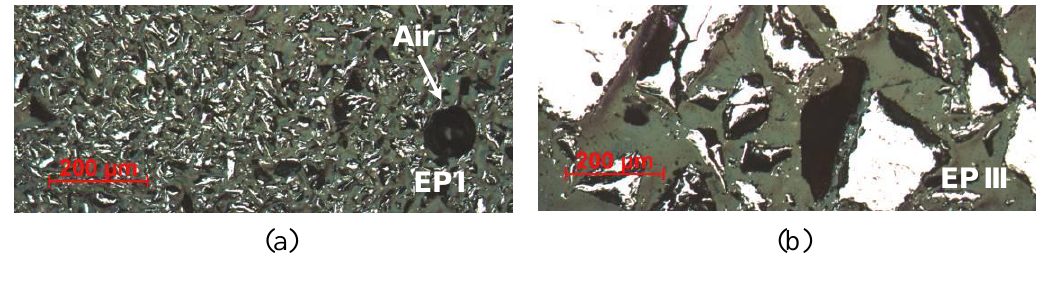
Figure 3. Cross section micrographs of specimens in Group D with particle sizes: (a) smaller than 50 µm (Class I); (b) larger than 200 µm (Class III).